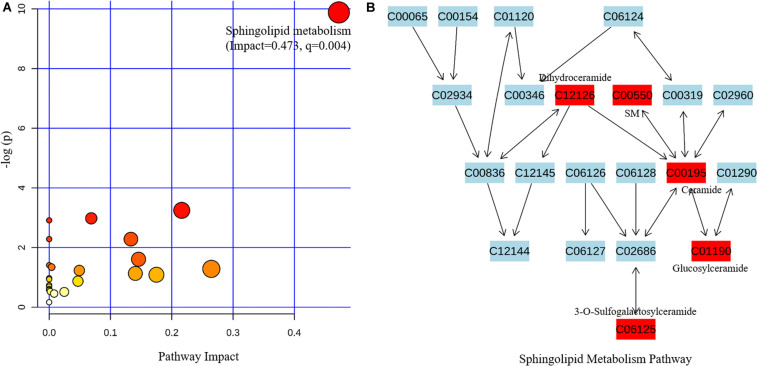
Metabolic pathway analysis based on the differentially expressed metabolites from the metabolomics data using MetaboAnalyst4.0. (A) Pathway analysis indicates sphingolipid metabolism is the only statistically enriched pathway. (B) In the sphingolipid metabolism pathway there are five differentially expressed metabolites involved, and all of them have increased in patients with Parkinson’s disease.